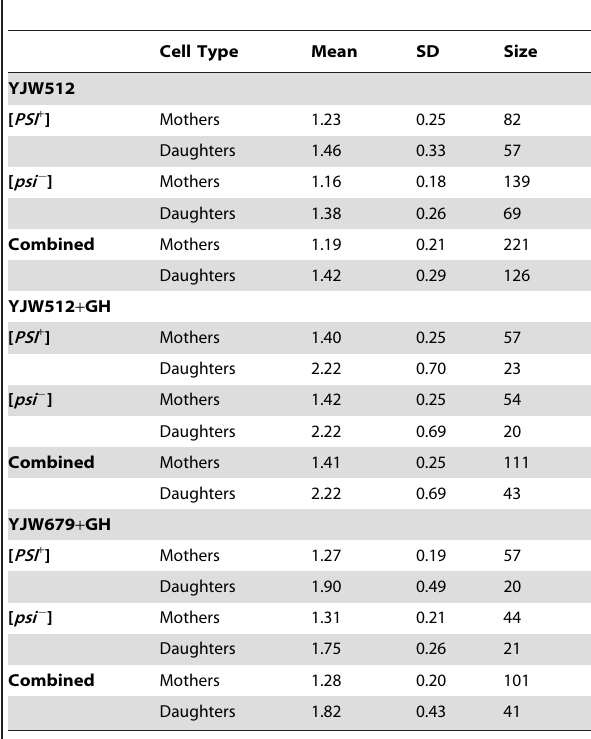
t =0 to a growing culture and the proportion of cells in the culture Table 2. Cell reproduction data for the strains YJW512 [ PSI + ]